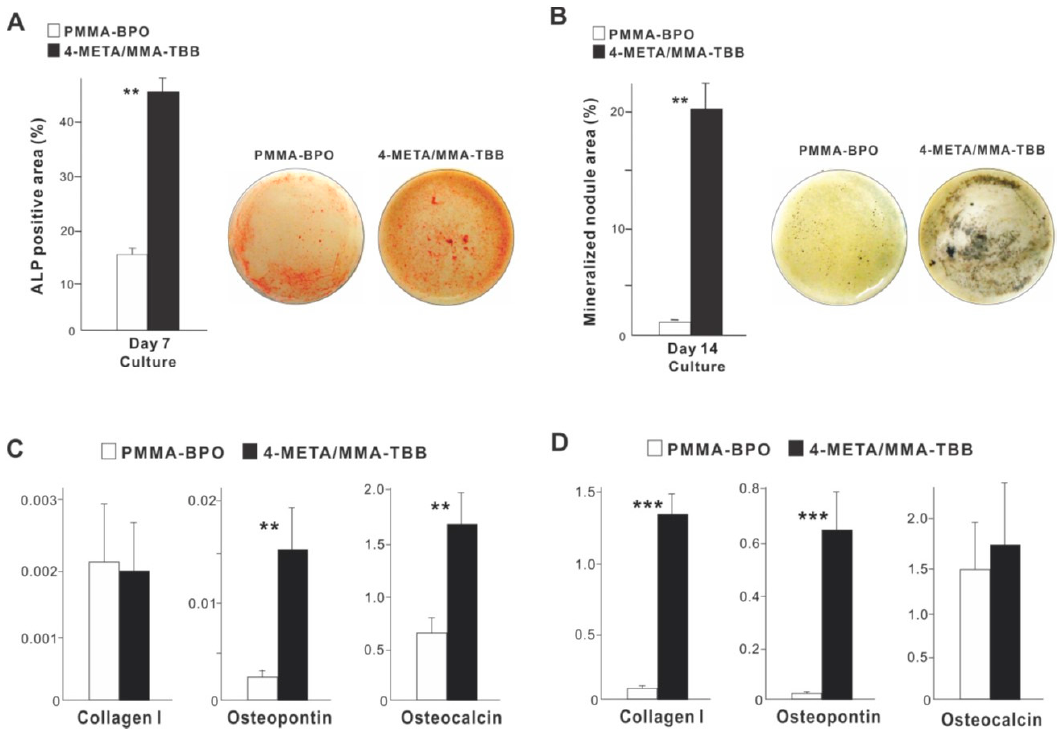
Figure 6. Functional differentiation and phenotypes of osteoblasts cultured on two different materials. ( A ) Images of cultures after alkaline phosphatase (ALP) staining on day 7 and ALP-positive area (%) measured using those images. ( B ) Mineralization capability of osteoblast cultures evaluated on day 14. Photos with von Kossa stain and von Kossa-positive area are shown. The expression of osteogenic genes evaluated by real-time quantitative PCR on days 3 ( C ) and 10 ( D ) of culture. * p < 0.05, ** p < 0.01, *** p < 0.001, statistically significant difference between the two materials.